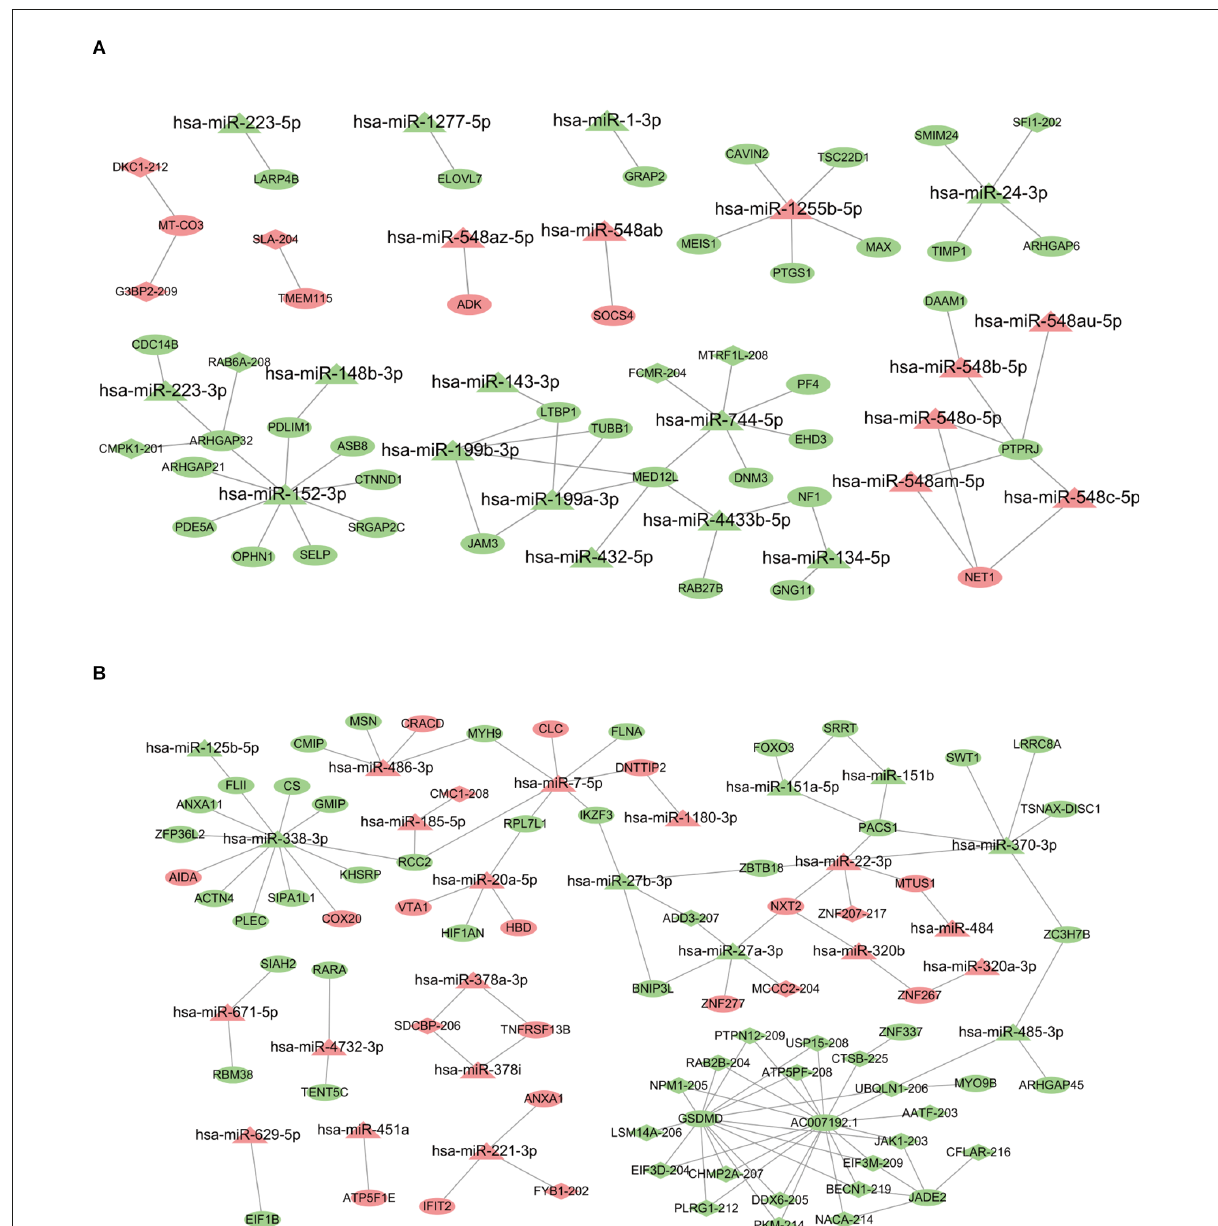
FIGURE4 LncRNA-miRNA-mRNA regulatory network associated with AW and PW stage. (A) The network related to the AW stage consists of 22 miRNAs, eight lncRNAs, and 38 mRNAs. (B) The network related to the PW stage consists of 24 miRNAs, 25 lncRNAs, and 50 mRNAs. Quadrilateral represents lncRNAs, triangle represents miRNAs, and ellipse represents